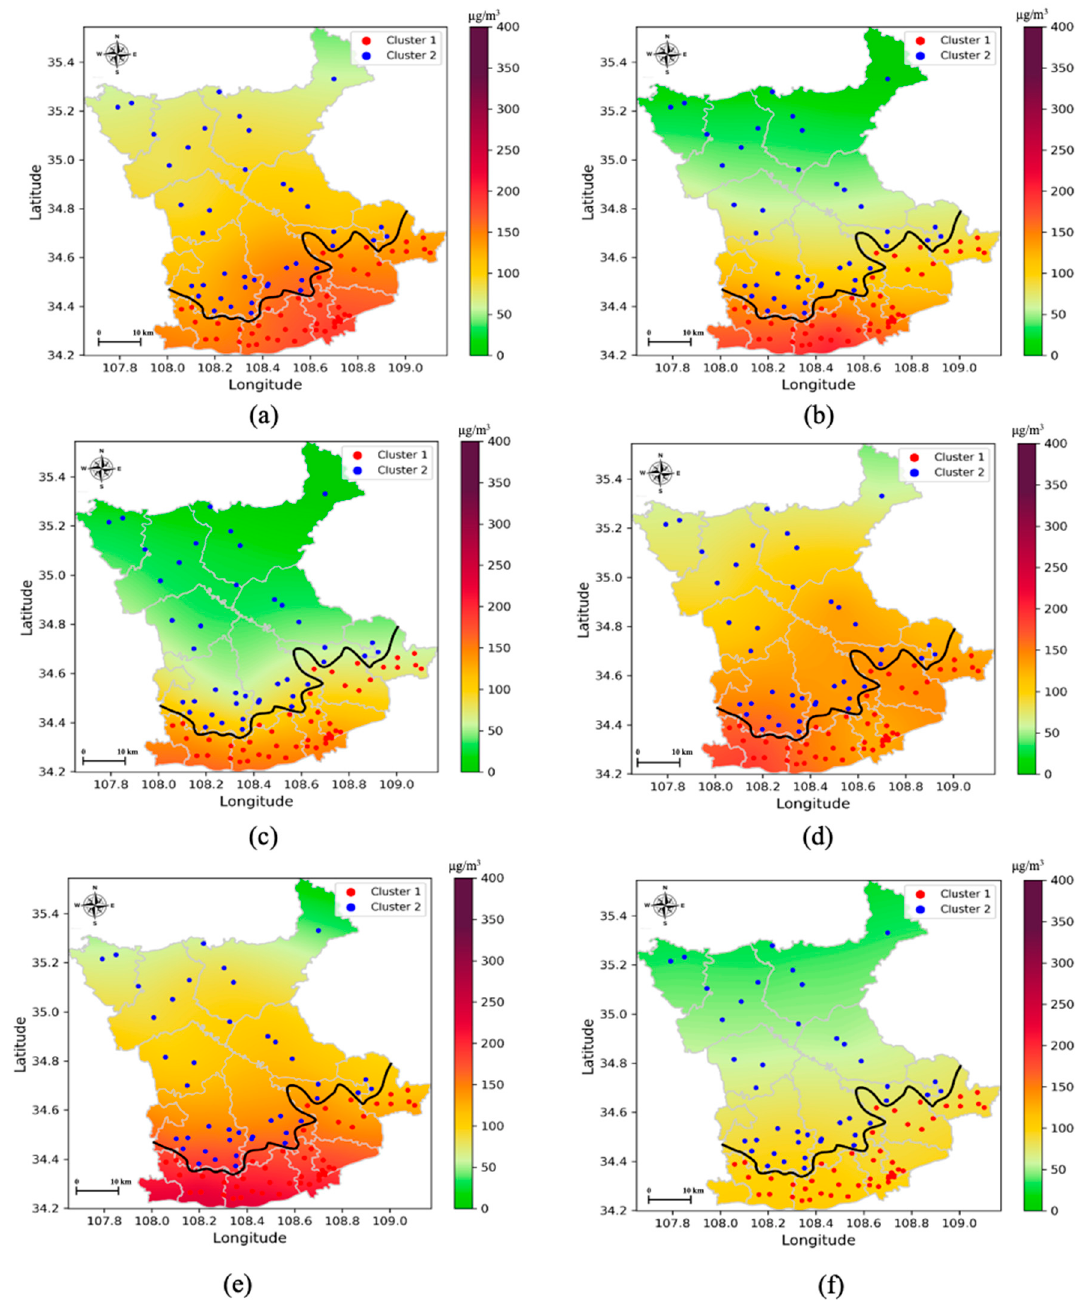
Figure 6. Heavy pollution process during level two emergency response days in 2020. 9 January